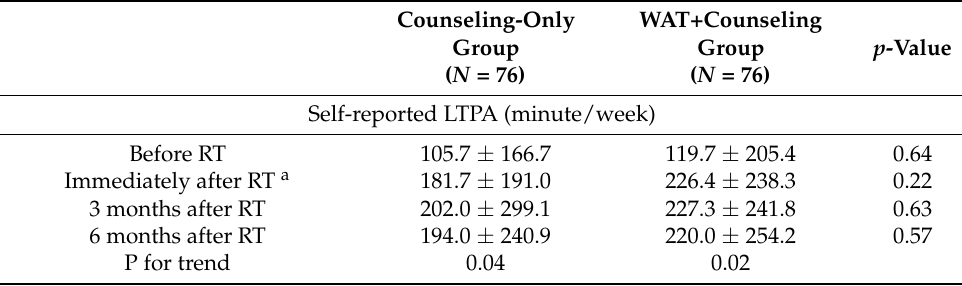
Table 2. Relative changes in self-reported LTPA by